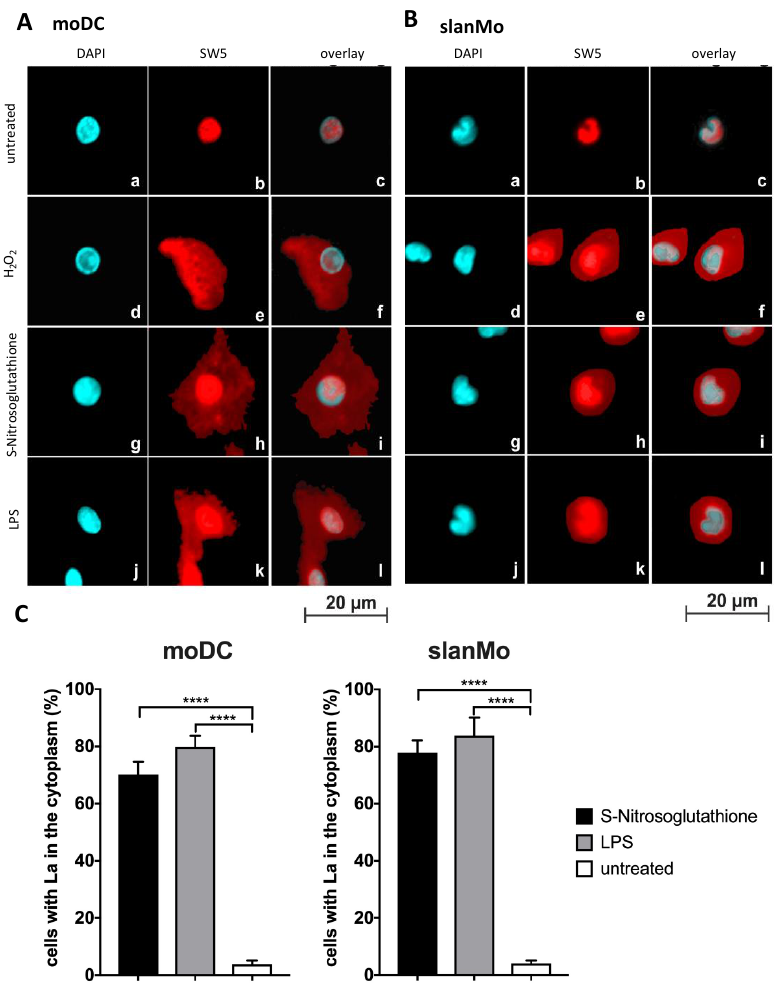
Figure 5. Shuttling of La protein in moDCs or slan monocytes (slanMos). ( A , B ) MoDCs and slanMos were stained with DAPI ( a , d , g , j ) or the anti-La mAb SW5 ( b , e , h , k ). The overlay of both channels is shown ( c , f , i , l ). ( a – c ) Untreated cells. ( d – f ) Cells treated with H 2 O 2 . ( g – i ) Cells treated with S-Nitrosoglutathione. ( j – l ) Cells treated with LPS. ( C ) Quantitative evaluation. p Value < 0.0001 = ****.